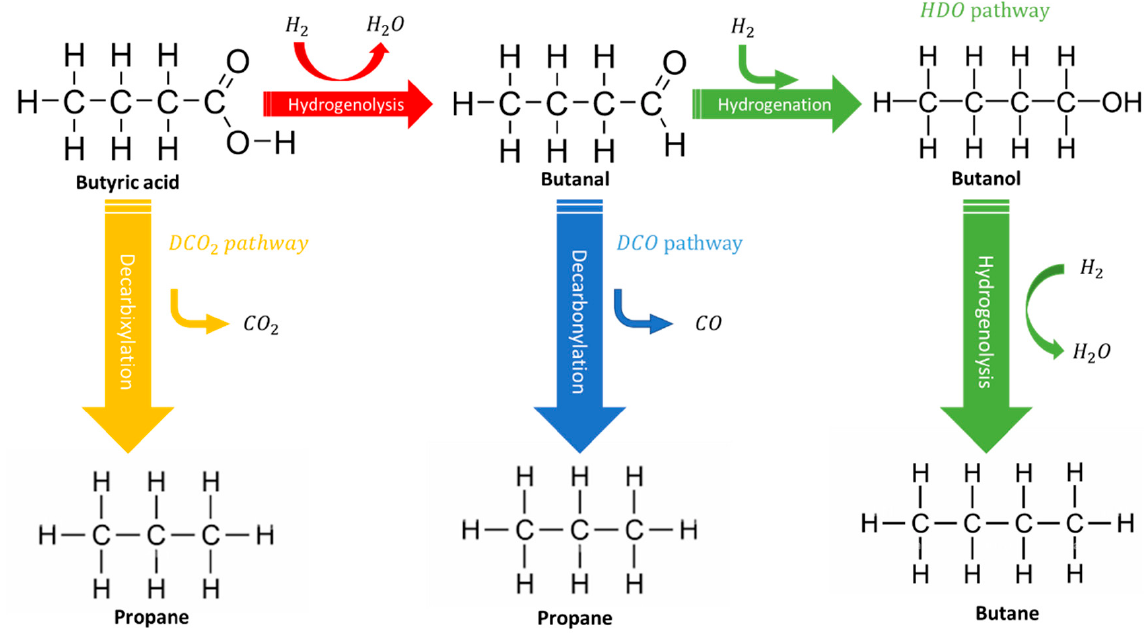
Figure 13. The proposed decarboxylation (DCO 2 ), decarbonylation (DCO) and hydrodeoxygenation (HDO) mechanisms for deoxygenation process. Adapted from Ref. [168].